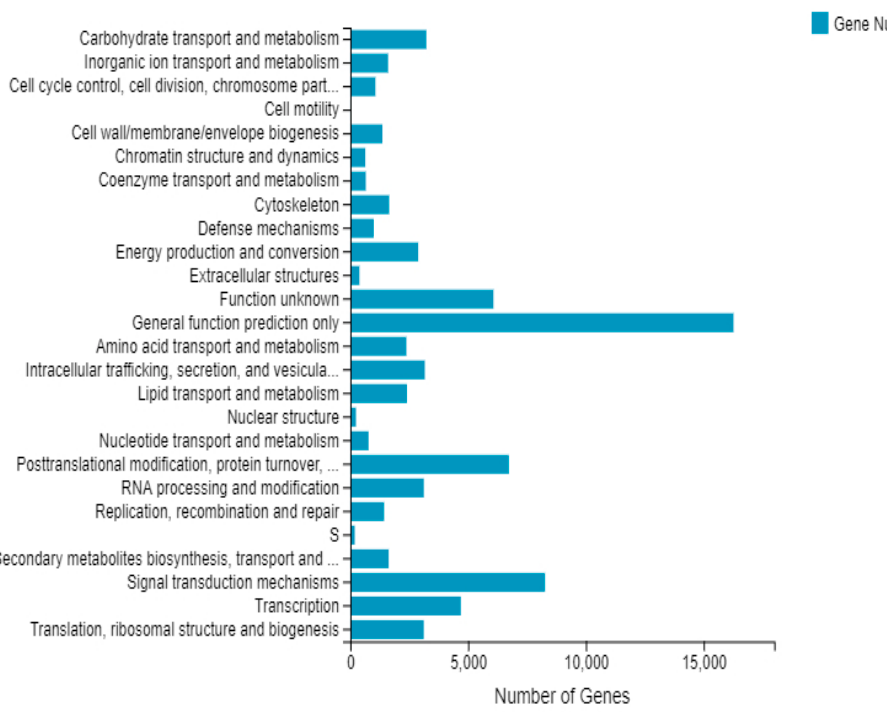
Figure 1. Functional classification of KOG.The X -axis represents the corresponding number of Unigene and the Y -axis represents the name of KOG functional classification.